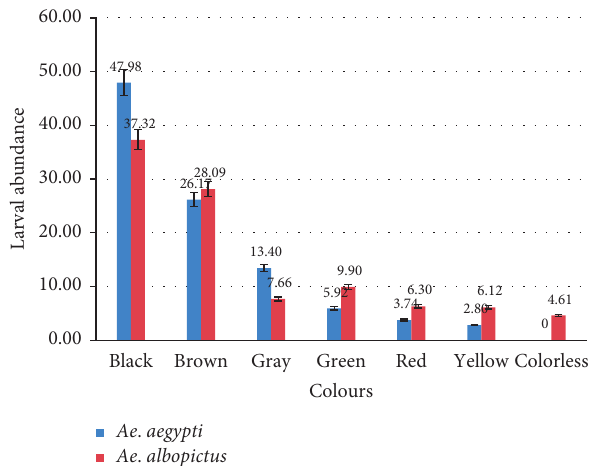
Figure 5: Relative larval abundance of Aedes spp. in containers with different colors.